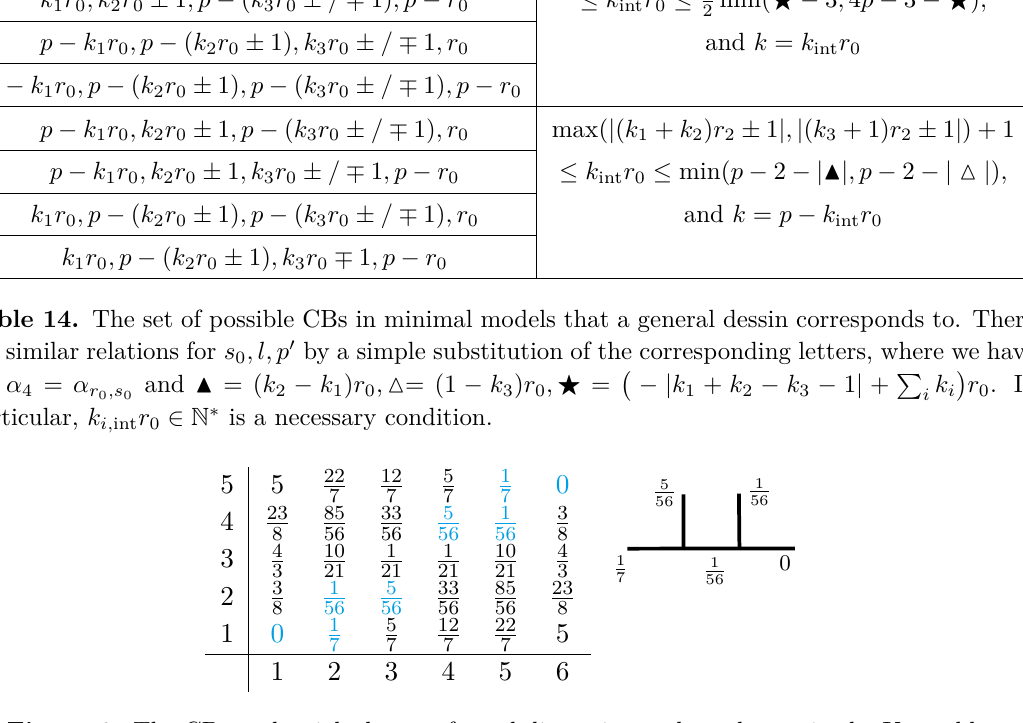
Figure 6. The CB on the right has conformal dimensions coloured cyan in the Kac